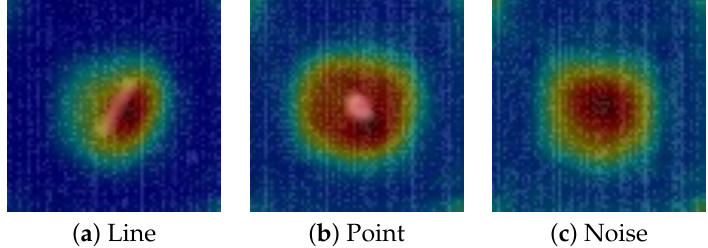
Figure 4. The gradient heatmaps for our 3 classes (computed using GradCam [18]).